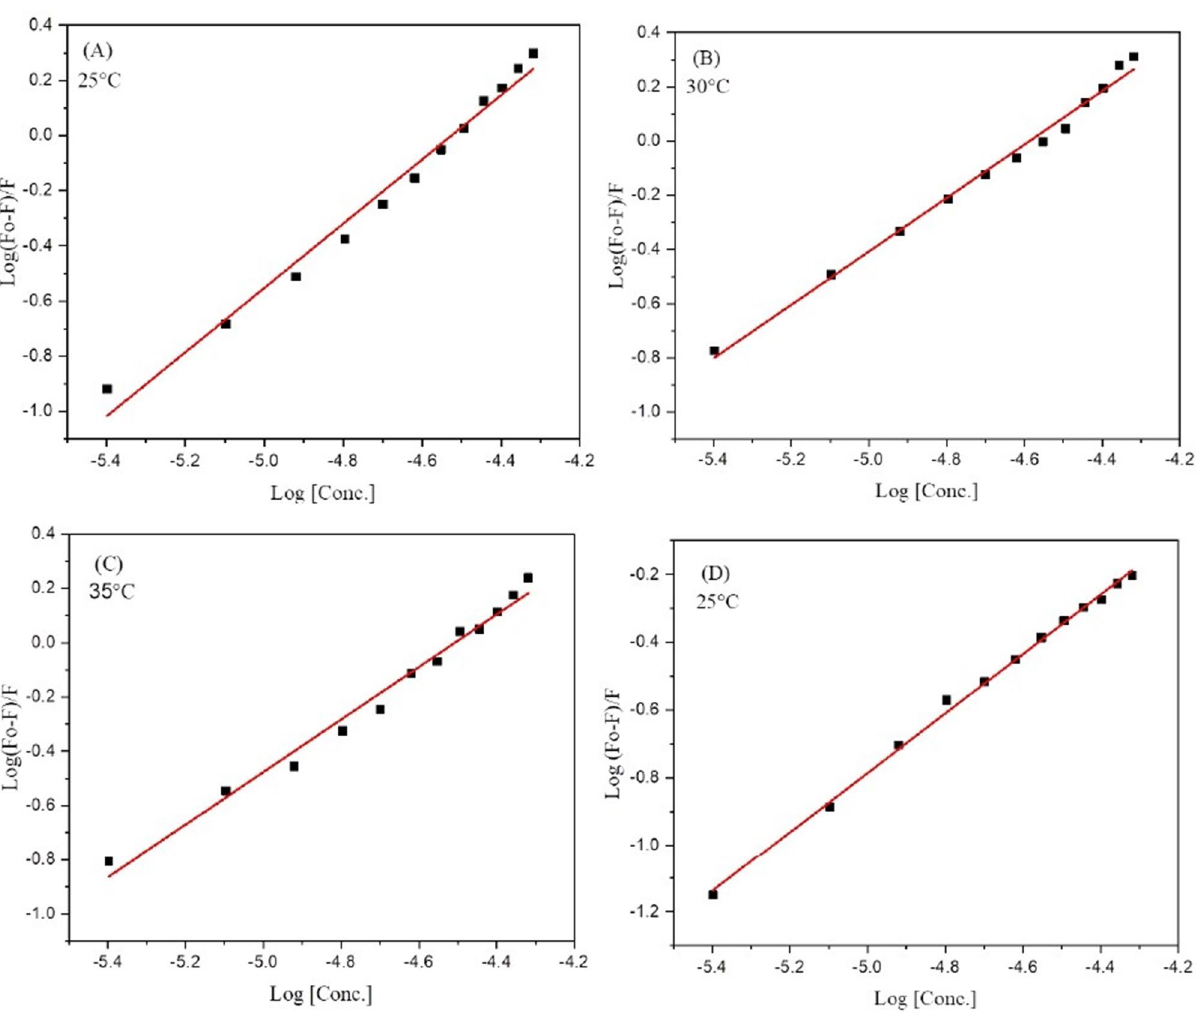
Figure 12. Modified Stern–Volmer plots for the DNA/BSA- 4g complex system ( A ) BSA-4g complex at 25 °C; ( B ) BSA-4g complex 30 °C; ( C ) BSA-4g complex at 35 °C; ( D ) DNA-4g complex at 25